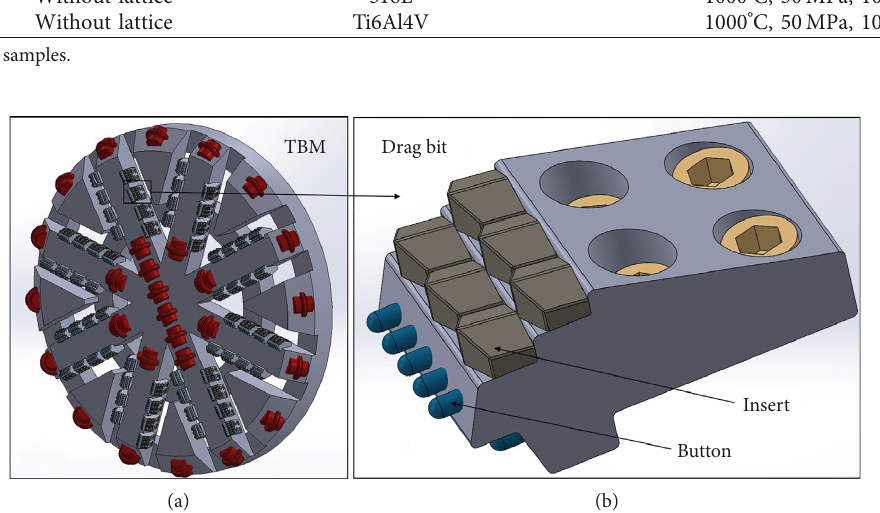
Figure 4: Schematic illustration of tunnel boring machine cutterhead (a), position of buttons and inserts in the drag bit (b) (TBM diameter is 3000mm and drag bit dimension is 195 × 115 × 90mm).